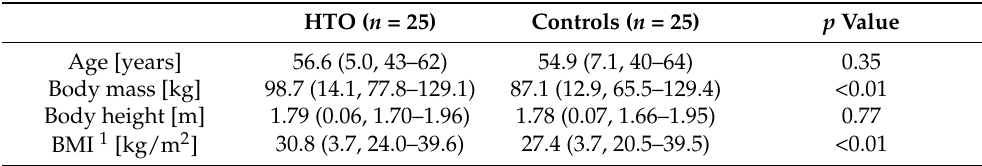
Table 1. Baseline demographic characteristics of the study participants. Values presented as mean (SD, minimum and maximum).